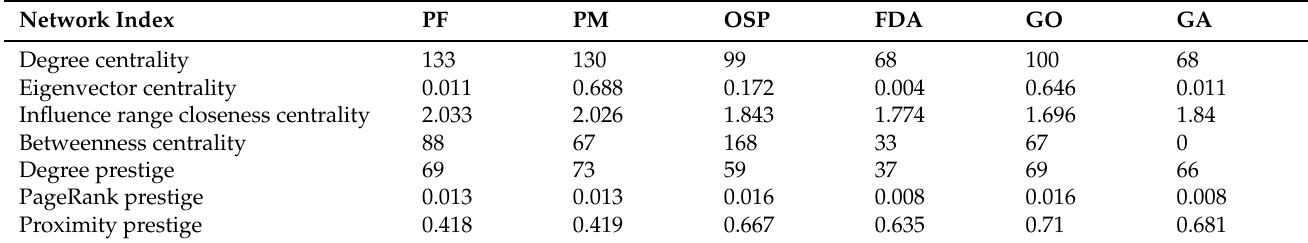
Table 4. Node-level metrics of TCO and SPO network